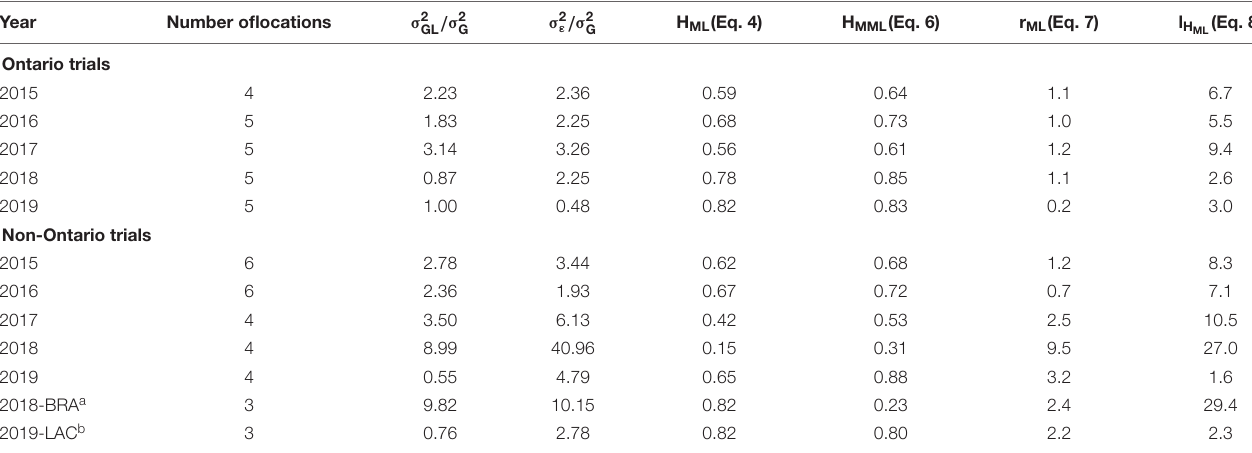
TABLE 3 | The ratio of genotype by location interaction variance over genotypic variance ( σ 2 GL / σ 2 G ),the ratio of experimental error variance over genotypic variance ( σ 2 / σ 2 G ), the estimated optimum number of replicates on the multi-location basis ( r ML ), and estimated number of locations for adequate testing( l HML ) for theOntario and non-Ontario tests in individual